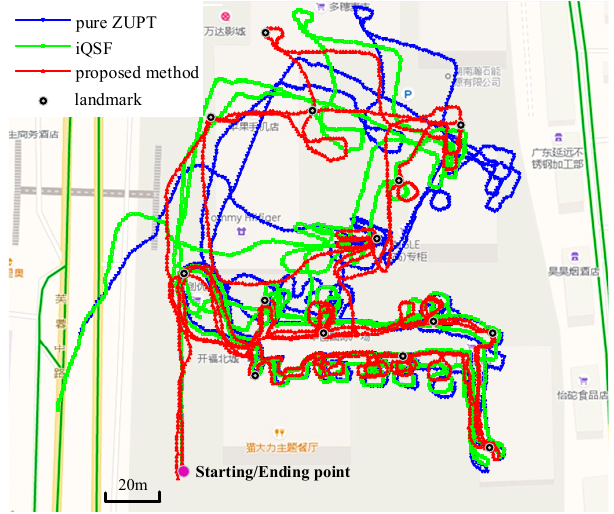
Figure 12. Trajectories obtained using pure ZUPT, iQSF and the proposed method.